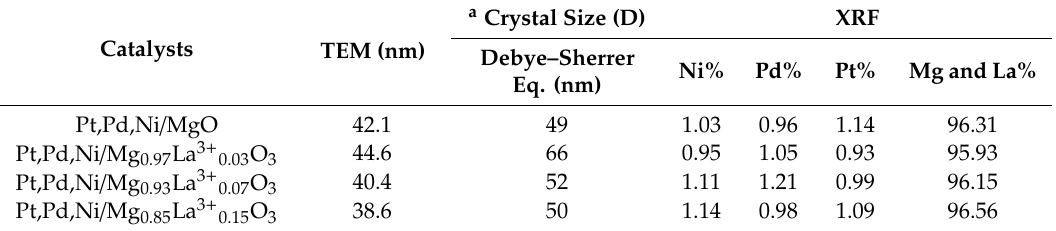
Figure 1. XRD patterns of the catalysts: ( a ) Pt,Pd,Ni/MgO, ( b ) Pd,Pd,Ni/Mg 0.97 La 3+0.03 O, ( c ) Pd,Pd,Ni/Mg 0.93 La 3+0.07 O, ( d ) Pd,Pd,Ni/Mg 0.85 La 3+0.15 O.